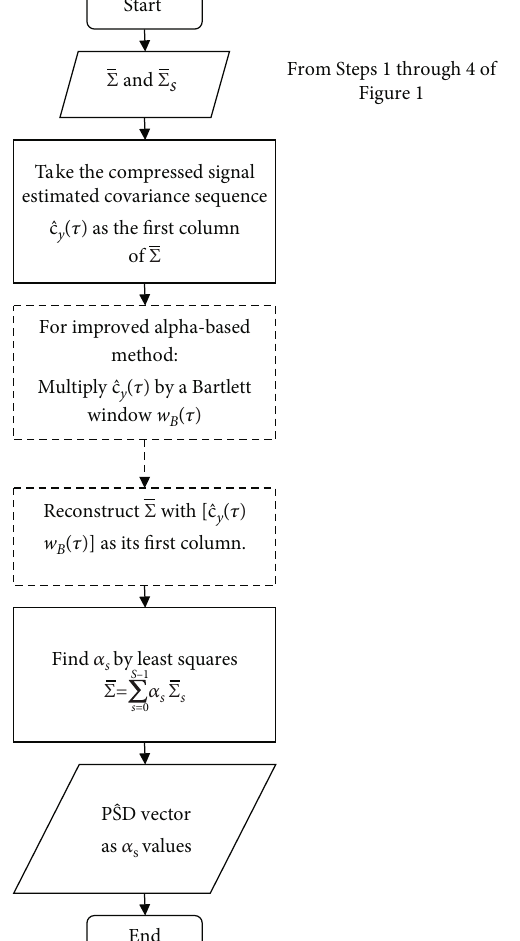
Figure 3: Flowchart of the alpha-based and improved alpha-based methods of power spectrum estimation using the Fourier basis for the Toeplitz subspace. The dashed boxes concern the proposed improved alpha-based method.